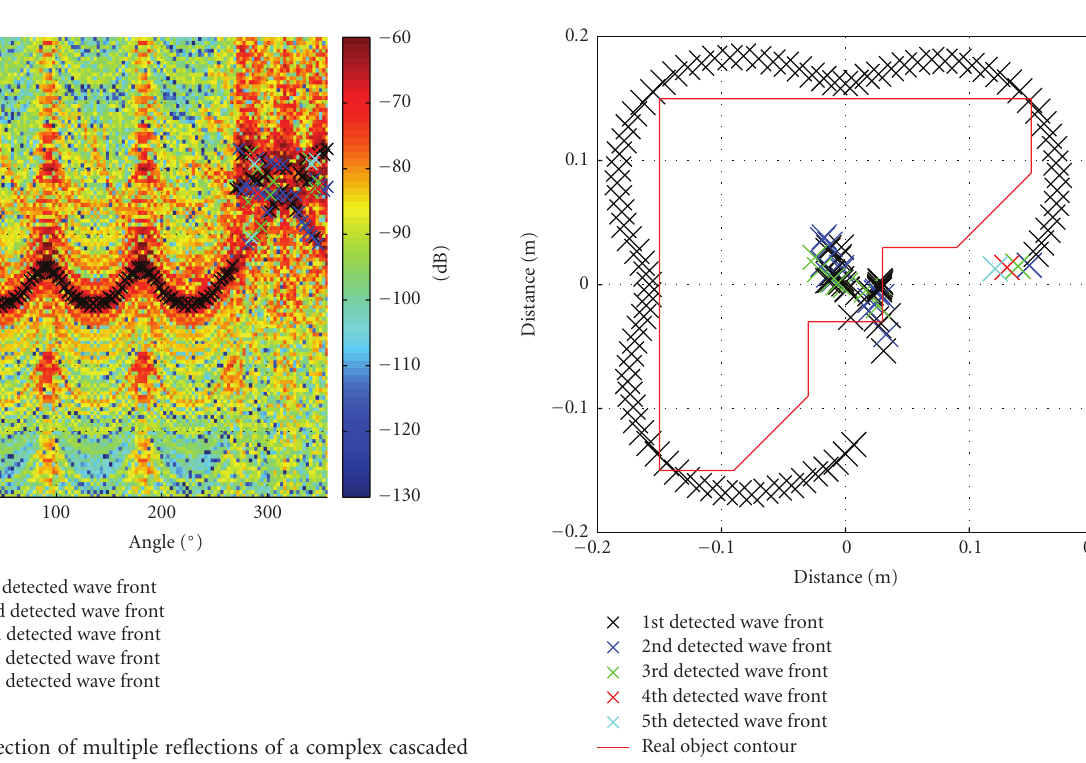
Figure 8: Polar diagrams of measured versus real object cross- section.